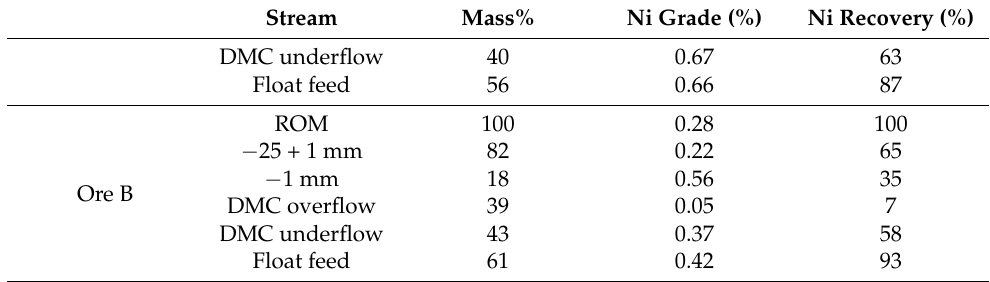
Figure 4. Bulk mineralogy of the DMC feeds as determined by QXRD, with average SGs given in brackets. The Fe-Ti oxides grouping includes magnetite, hematite, chromite, ilmenite and rutile. From the QXRD of the DMC products, separation of silicate minerals can be observed based on their density differences, in addition to the concentration of sulfide minerals in